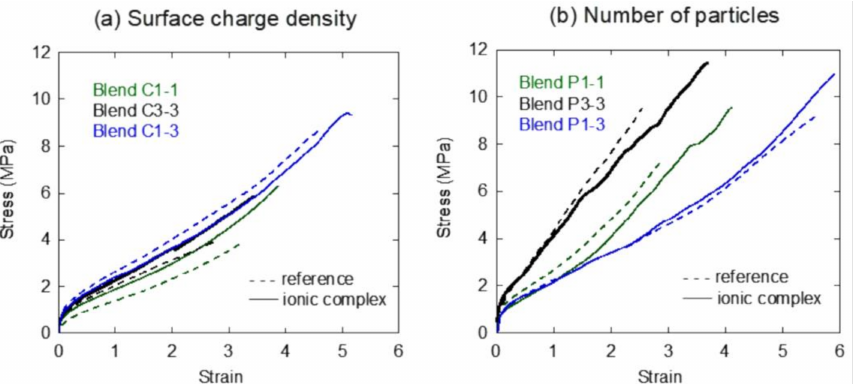
Figure 5. Mechanical properties measured at macroscopic level between oppositely charged polymer particles blends performed based on equal ( a ) surface charge density and ( b ) number of particles and at different pH. The dash lines represent the reference latex (pH > 7.5) while the continuous lines the ionic complex (pH <